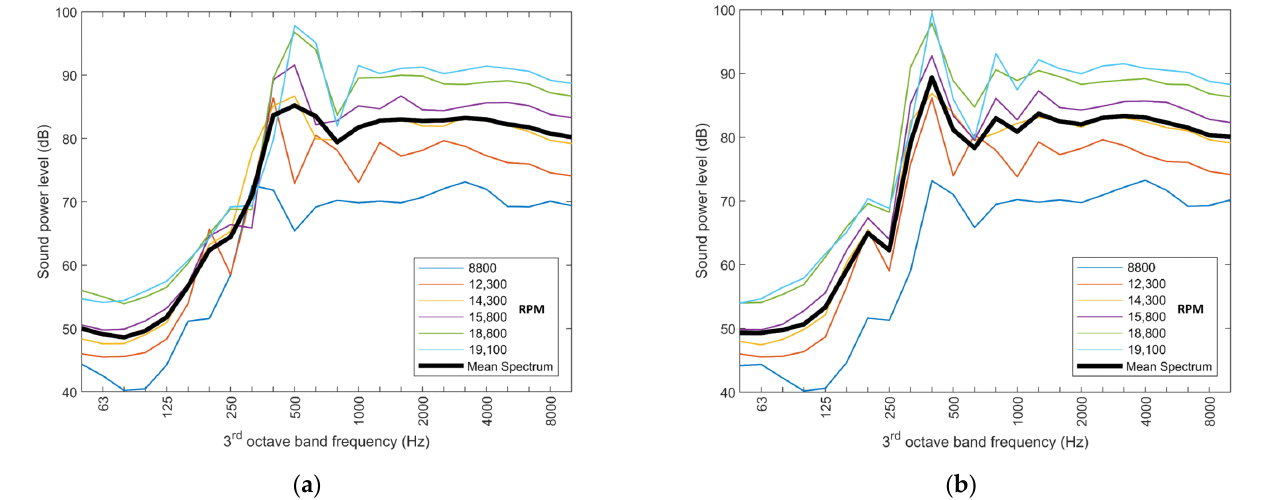
Figure 3. Sound power spectra of the SSE multicopter, derived from measurements at microphone M3 (radiation angle of 60°) for different RPM, ( a ) before and ( b ) after the pitch shift to the reference RPM .